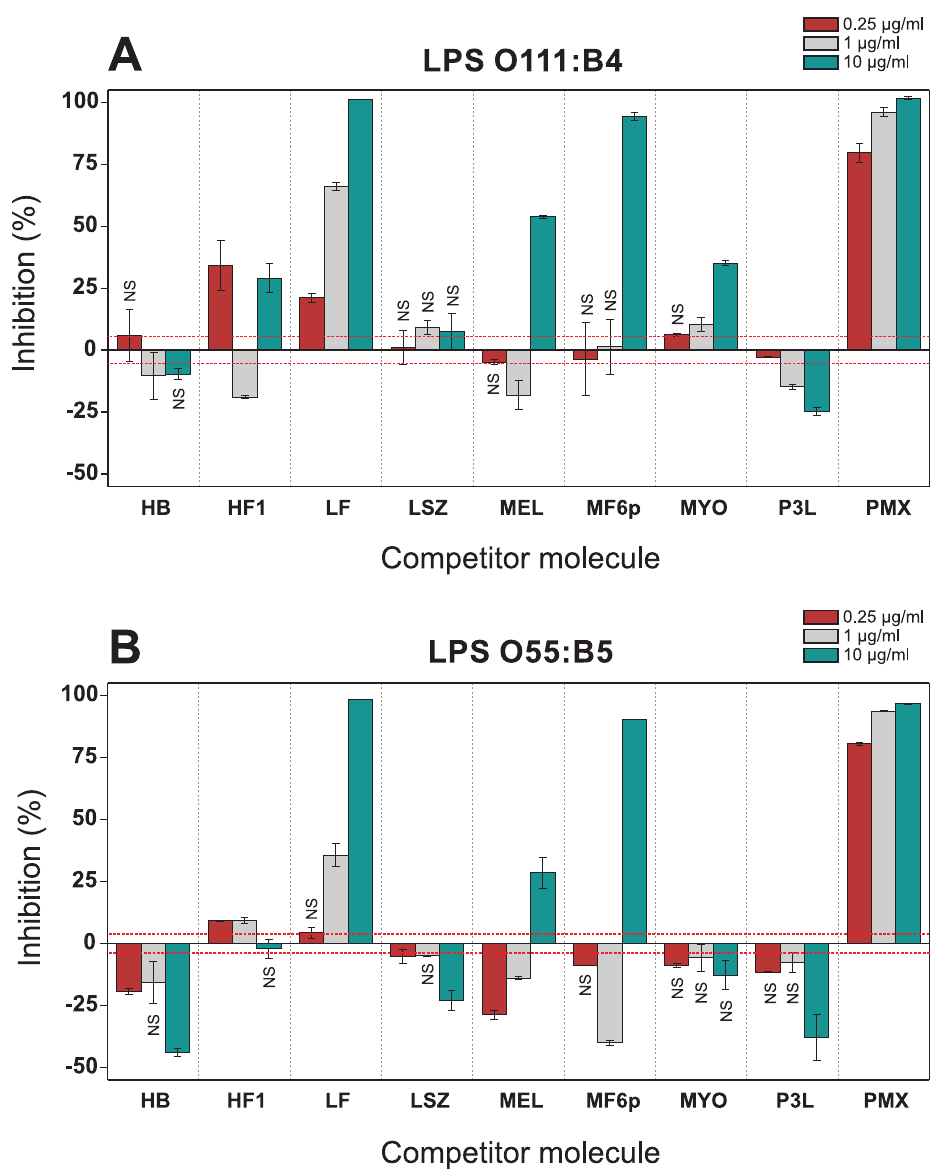
Fig 7. Competitive PMX-ELISA. FITC-LPSs from E . coli serotypes O111:B4 (A) and O55:B5 (B) were preincubated, at 1.25 and 2.5 μ g/ml, respectively, with three different concentrations of proteins and peptides (10, 1 and 0.25 μ g/ml) in PBS-EDTA with 0.1% BSA and added to wells containing biotinylated polymyxin B captured by deglycosylated avidin. Results are expressed as percentage inhibition of LPS binding to captured polymyxin B by the target protein/peptide, and are the mean values ± SD for duplicate wells. The average optical densities (492 nm) of control wells (without inhibitor) were 0.904 ( ± 0.042, red dashed line) and 0.842 ( ± 0.036, red dashed line) for serotypes O111:B4 and O55:B5, respectively. Differences were considered significant at p < 0.05. NS: not significant. HB, hemoglobin; HF1, histone f1 fraction; LF, lactoferrin; LSZ, lysozyme; MEL, melittin; MF6p, synthetic FhHDM-1/MF6p; MYO, myoglobin; P3L, A . simplex peptide: MCQCVQKYGTEFCKKRLA; PMX, polymyxin